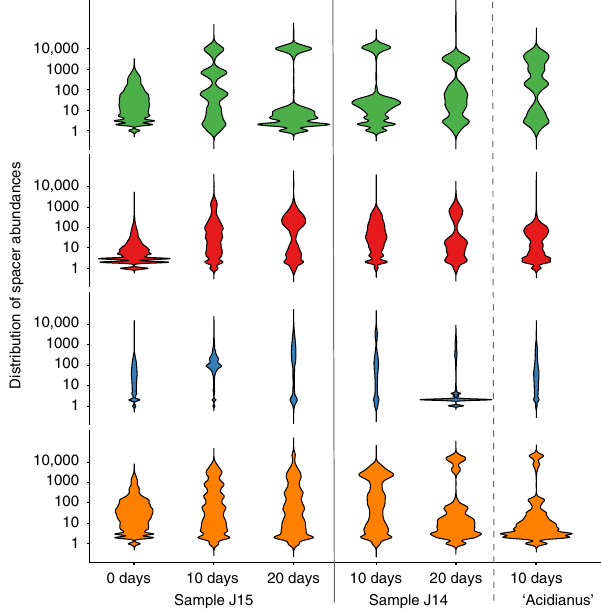
Fig. 2 The violin plots show the density of the distribution of spacer abundances in the environmental sample and enrichment cultures established from samples J14 and J15. In the J14 sample, the enrichment culture established in the Acidianus -favoring medium is separated from those established in the Sulfolobus/Saccharolobus -favoring medium by a dashed line. Plots in each row represent spacers, associated with different CRISPR consensuses and color-coded as in Fig. 1a. Plots in each row are scaled to have the same area. Log10 scale for the abundance values was used. Source data are provided as a Source Data fi